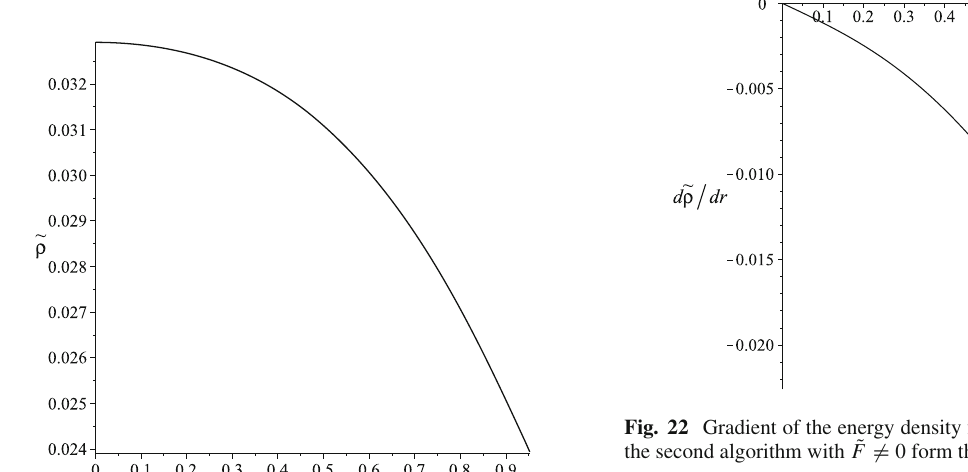
Fig. 19 Pressures for the solution obtained with the second algorithm with ˜ F (cid:9)= 0 form the isotropic Gold III solution